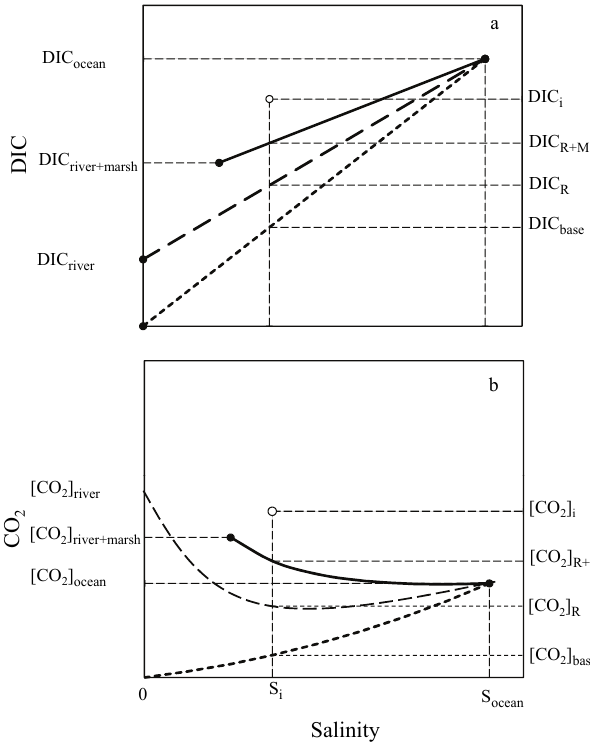
Fig. 2. Conceptual diagrams showing DIC and dissolved CO 2 con- centrations during continental shelf mixing. (a) DIC concentration vs. salinity. On the x-axis, S i and S ocean are the salinities of station i and the ocean end-member, respectively. On the y-axis, DIC ocean , DIC river + marsh and DIC river are DIC concentrations of the oceanic end-member, nearshore end-member (containing DIC from both the river and marsh), and the river end-member, respectively. On the right side, DIC i is the in situ DIC concentration, and DIC R + M , DIC R , and DIC base are the DIC concentrations at the salinity of S i assuming the ocean end-member is mixed only with the nearshore end-member (containing DIC from both the river and marsh), the river end-member, and zero-DIC freshwater end-member, respec- tively. (b) Dissolved CO 2 concentrations vs. salinity. The corre- sponding p CO 2 can be calculated according to p CO 2 = k H · (CO 2 ), where k H is Henry’s